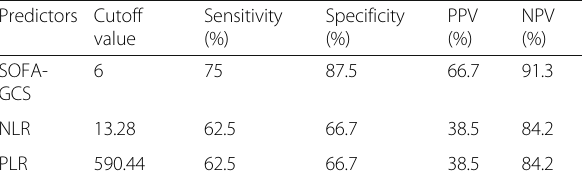
Table 5 Performance parameters for predictors of mortality Predictors Cutoff value